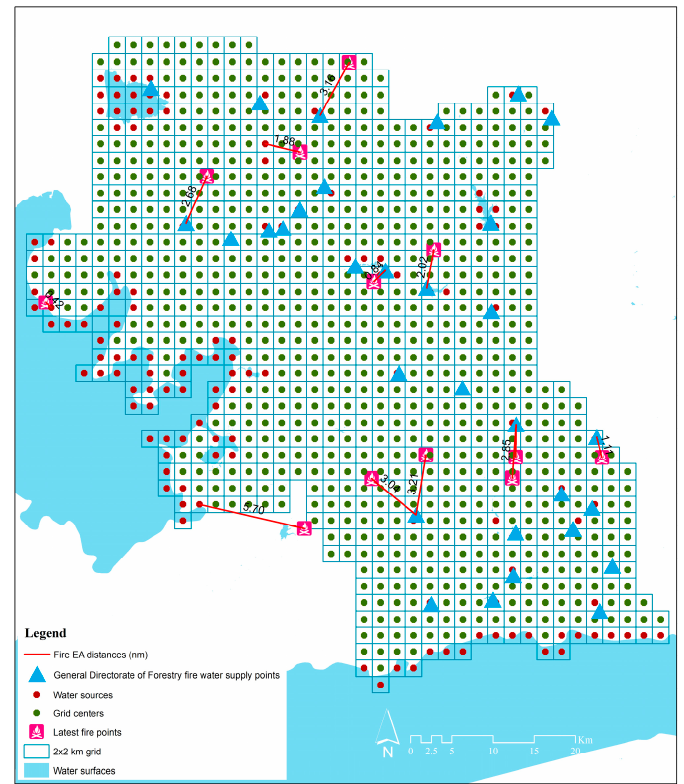
Figure 24. EA times in the current situation.